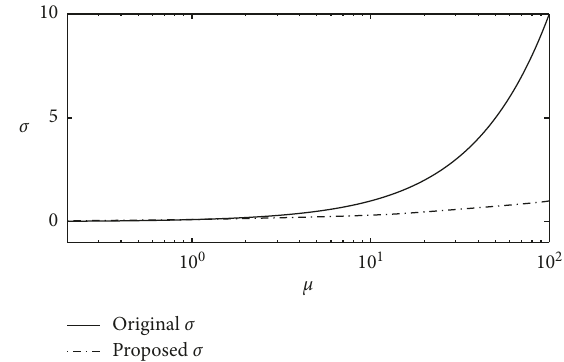
Figure 12: Difference between σ ′ in (6) and σ in (5) according to mean values of measurements.